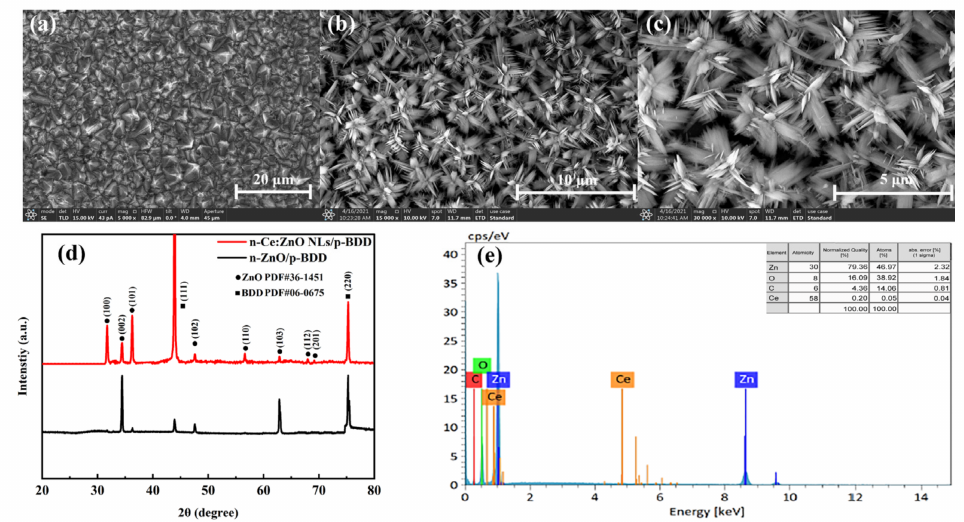
Figure 1. ( a ) SEM of the BDD substrate. ( b , c ) SEM of Ce:ZnO NLs deposited on the BDD substrate, respectively. ( d ) XRD spectrum of the n-Ce:ZnO NL/p-BDD heterojunction and